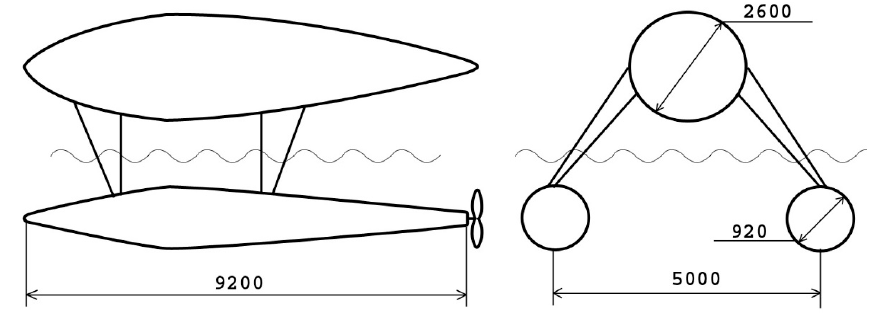
Figure 6. Sketch of SWATH low drag yacht.